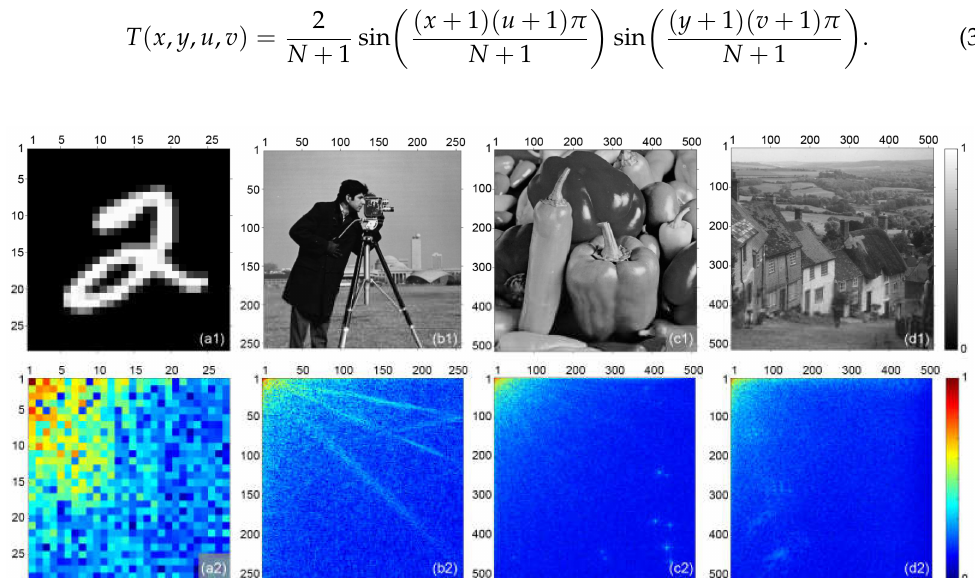
Figure 2. Natural images and their DST spectra: ( a1 ) handwritten digit “2” image (28 × 28 pixels), ( a2 ) DST spectrum of ( a1 ), ( b1 ) “Cameraman” image (256 × 256 pixels), ( b2 ) DST spectrum of ( b1 ), ( c1 ) “Peppers” image (512 × 512 pixels), ( c2 ) DST spectrum of ( c1 ), ( d1 ) “Goldhill” image (512 × 512 pixels), and ( d2 ) DST spectrum of ( d1 ).